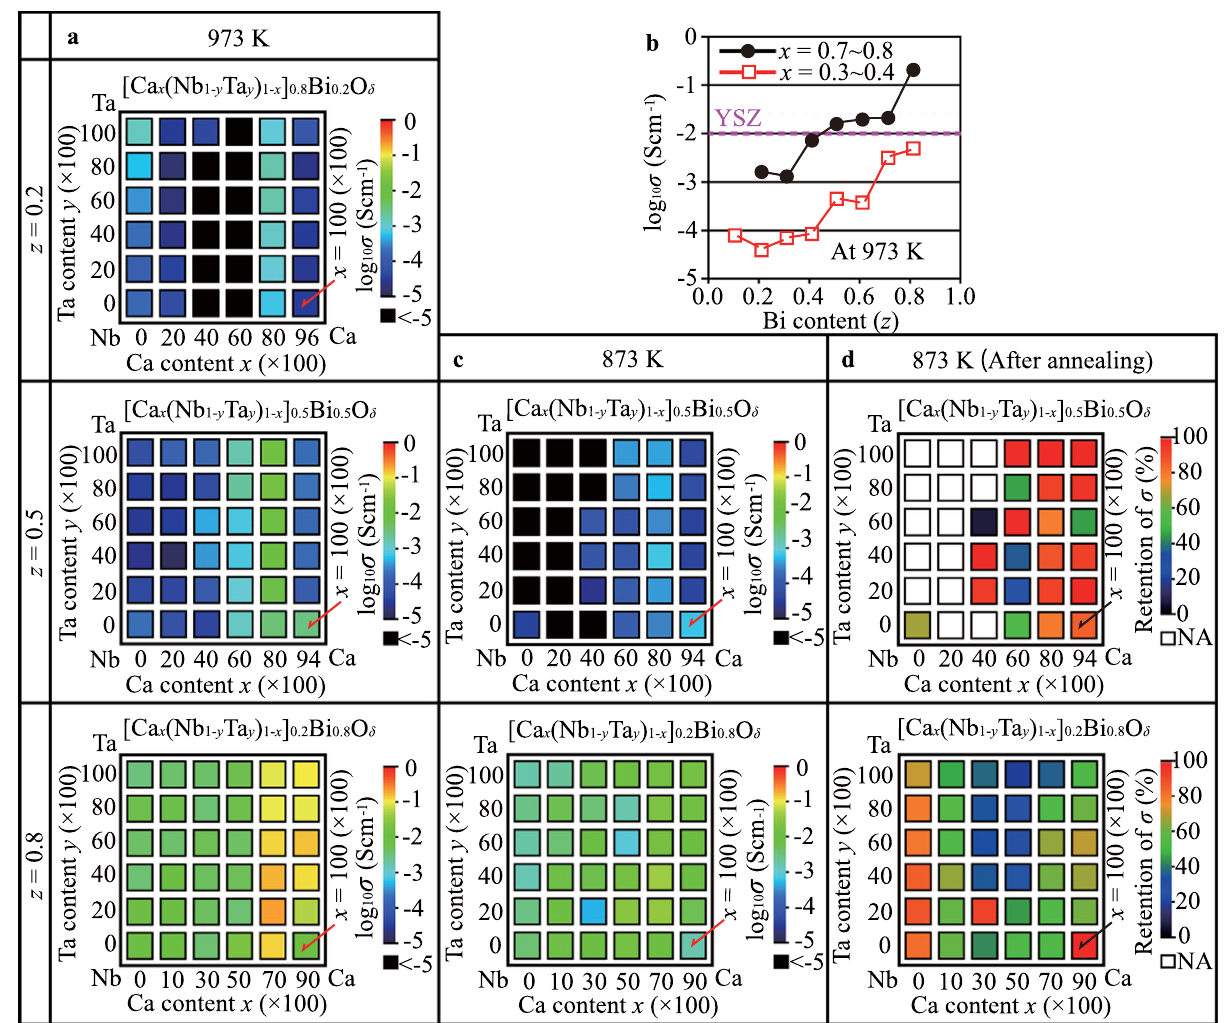
Fig. 3 Conductivity ( σ ) and thermal stability mapping of library fi lms with the composition [Ca x (Nb 1 − y Ta y ) 1 − x ] 1 − z Bi z O δ . a Conductivities of samples in which z = 0.8, 0.5, or 0.2 at 973 K. b Effects of Bi content ( z ) and Ca content ( x ) on the conductivities of library fi lms at 973 K. The conductivity of YSZ is also shown for comparison 24 . The highest conductivities in the third column from the left and those in the second column from the right in ( a ) are plotted as a function of z . c Conductivities of samples in which z = 0.8 or 0.5 at 873 K. d Retentions of conductivity (%) after annealing at 873 K for 5 h for the library with initial conductivities of ( c